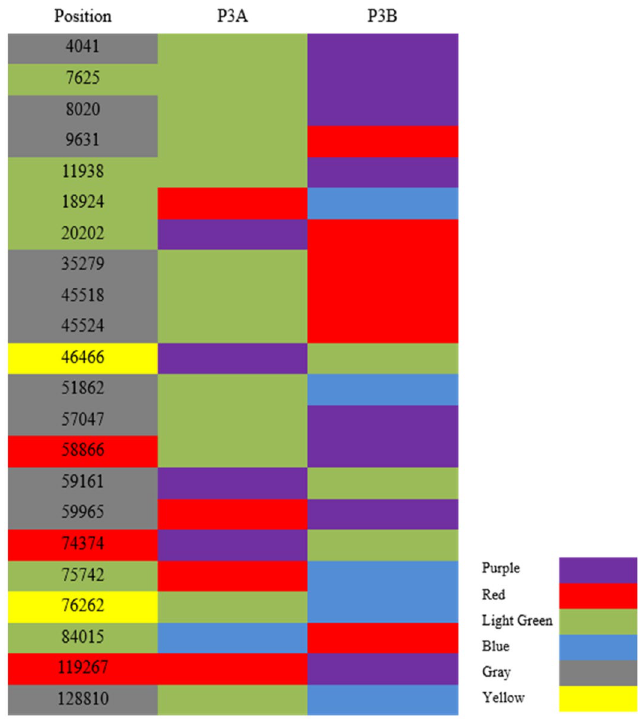
Figure 6. SNPs in gene coding region, gene intron and intergenic region between P3A and P3B. Note: DNA bases of P3A and P3B, guanosine (purple), thymine (red), adenine (light green), cytosine (blue). Position (red), nonsynonymous SNP in the CDS; Position (light green), synonymous SNP in the CDS; Position (yellow), SNP in the intron; Position (gray), SNP in the intergenic. Excel software was used for data processing and graph analysis.